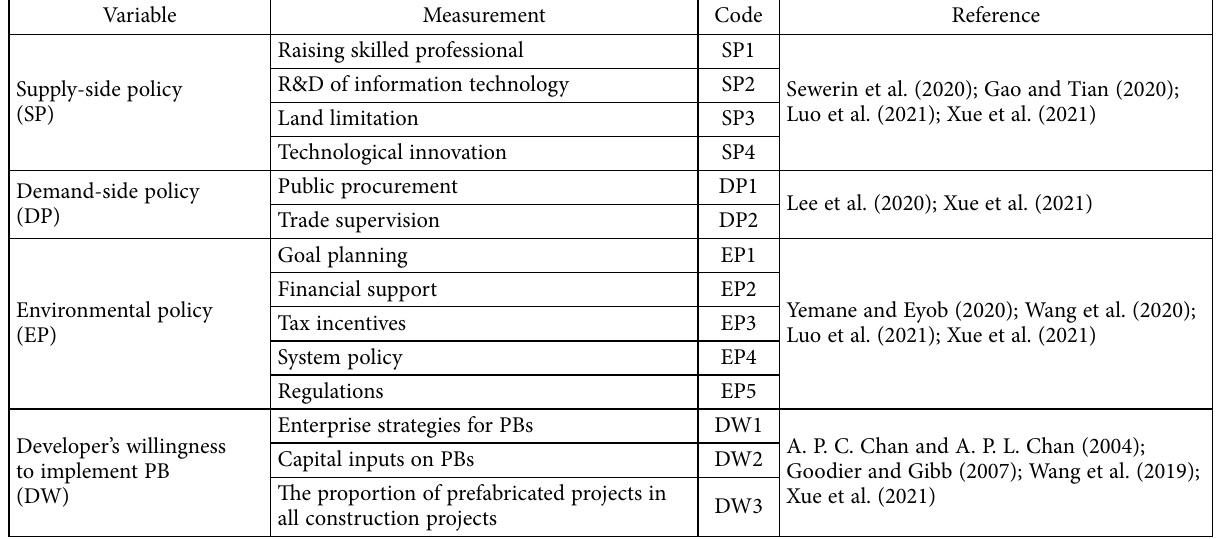
Table 2. Variables and the corresponding